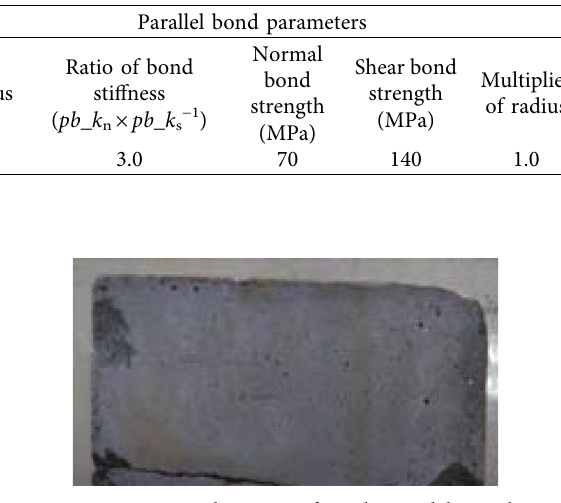
Table 3: Particles microscopic parameters of group C.